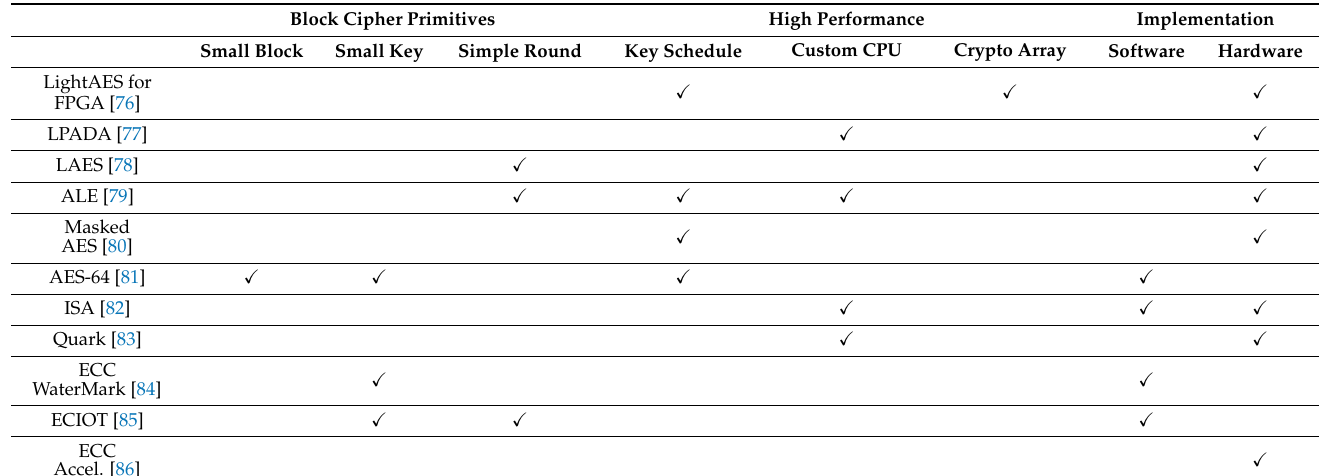
Table 7. Emerging lightweight approaches for IoT that are based on AES and ECC encryption. Block Cipher Primitives High Performance Implementation Small Block Small Key Simple Round Key Schedule Custom CPU Crypto Array Software